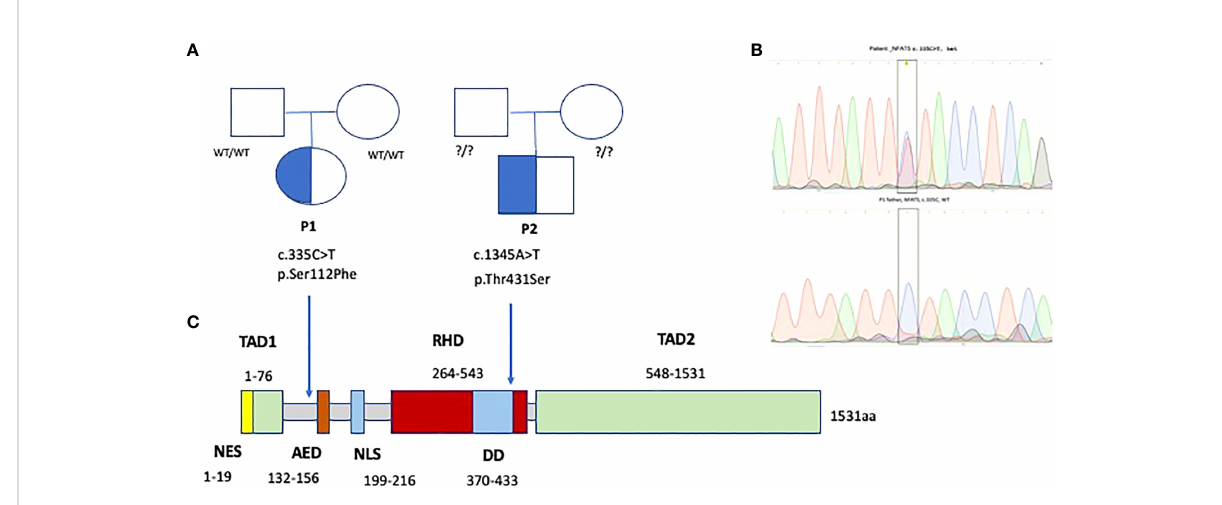
FIGURE 6 Family trees (A) and Sanger electropherograms (B) show de novo heterozygous missense variants in exons 4 and 7 of NFAT5 , affecting Transcription activation and DNA binding domains of NFAT5 (C) , in two patients with